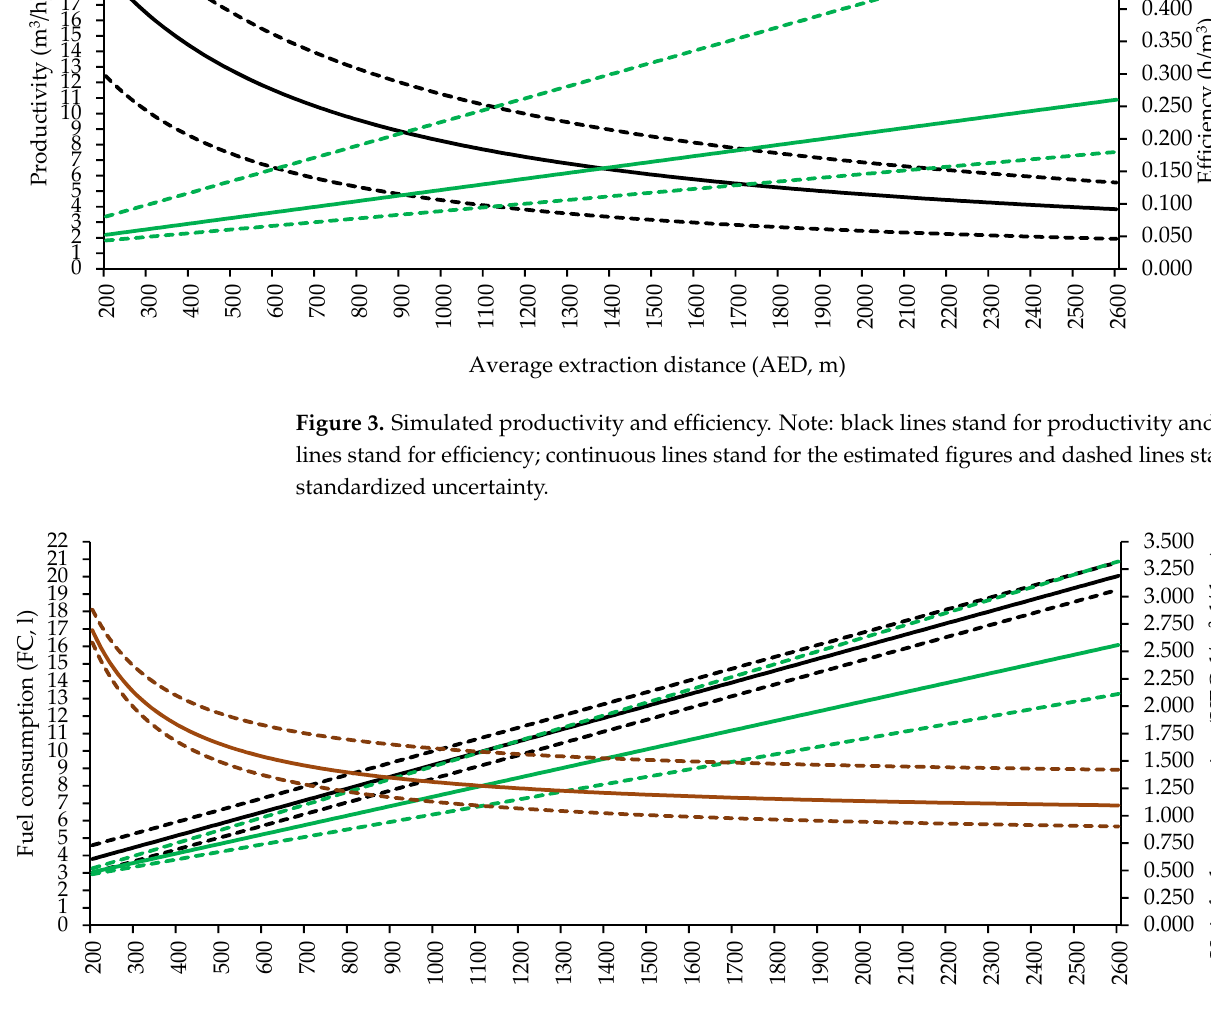
Figure 4. Simulated fuel consumption. Note: black lines stand for fuel consumption, green lines stand for unit fuel consumption expressed in L/m 3 , and brown lines stand for unit fuel consumption expressed in L/tkm; continuous lines stand for the estimated figures and dashed lines stand for standardized uncertainty.